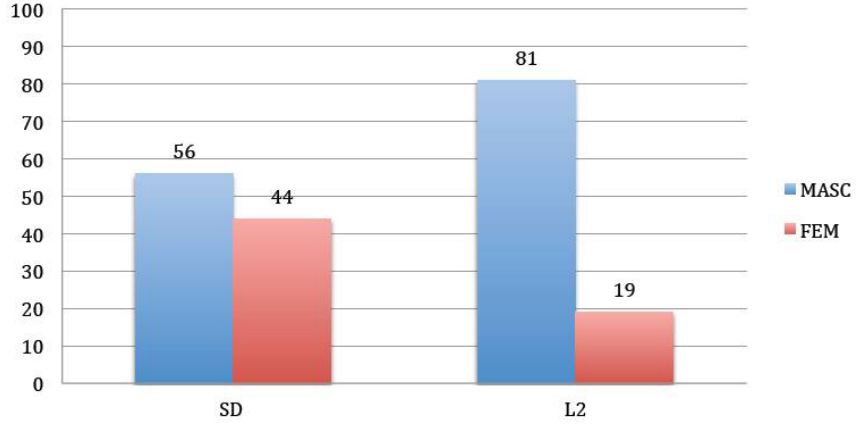
Table 6. Clitics according to clitic doubling structure. CLD